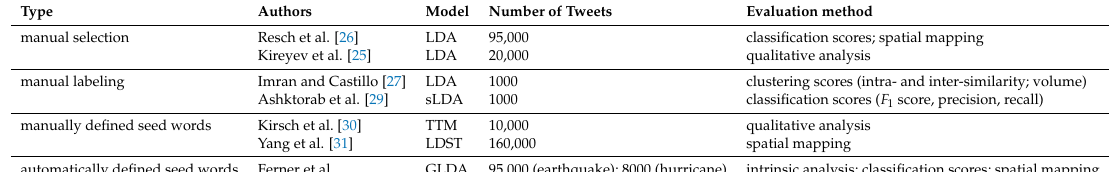
Table 2. Comparison of our approach (bottom) to related work concerning the methods used to incorporate prior information to the various model, dataset sizes and evaluation methods.